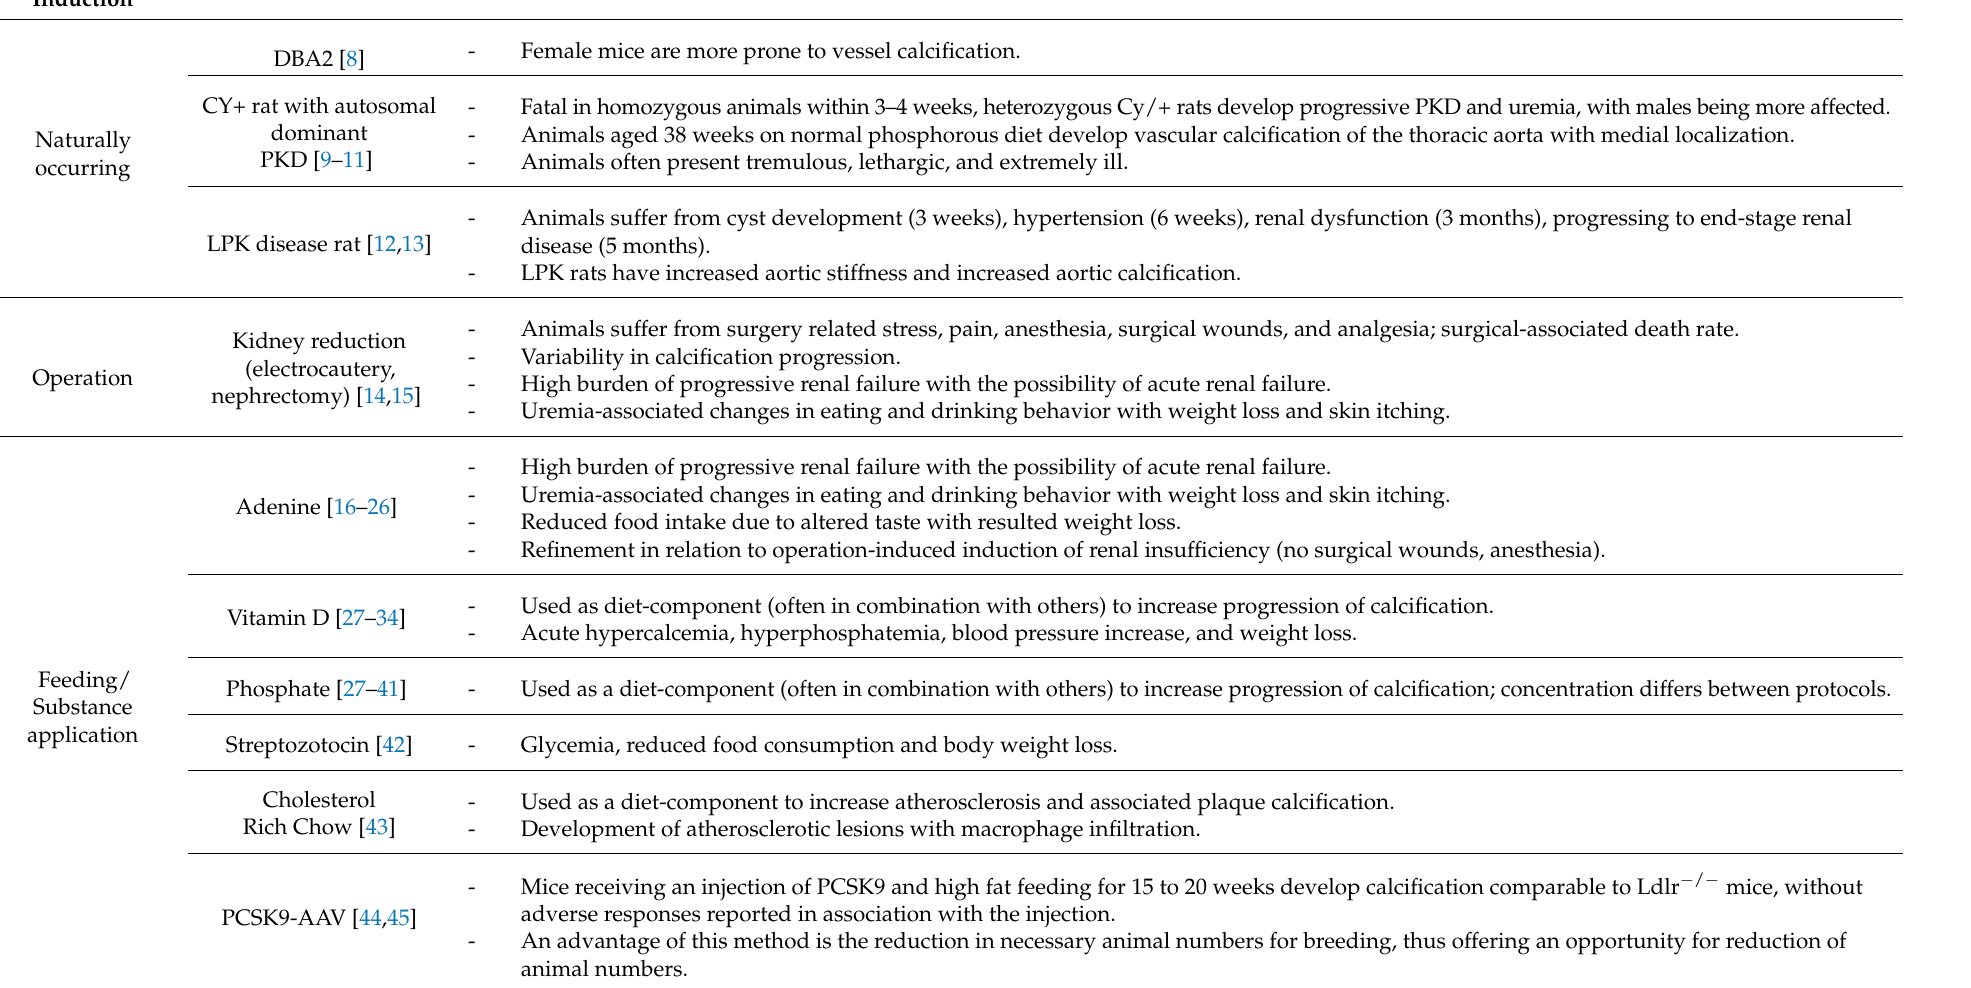
Table 1. Introduction of vascular calcification in various rodent models (modified after